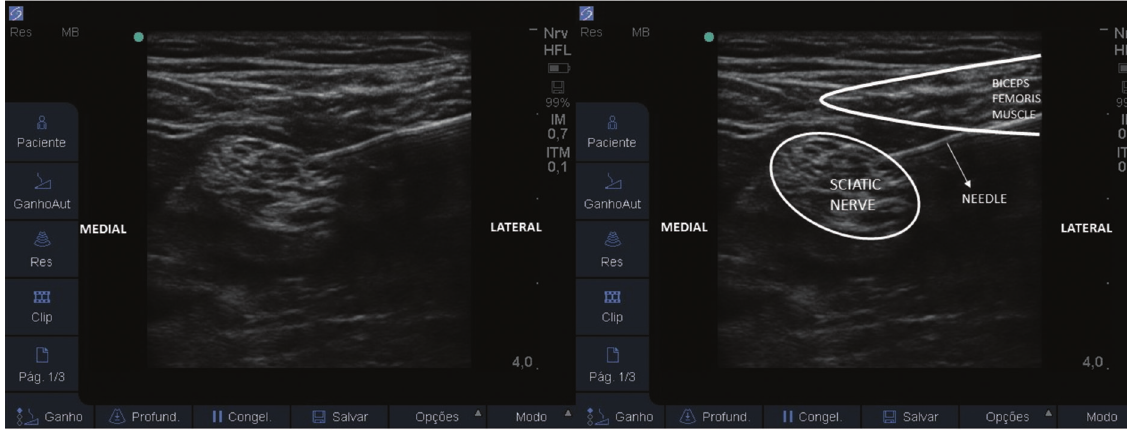
Figure 1 - US-guided sciatic nerve block and catheter installation, popliteal approach.